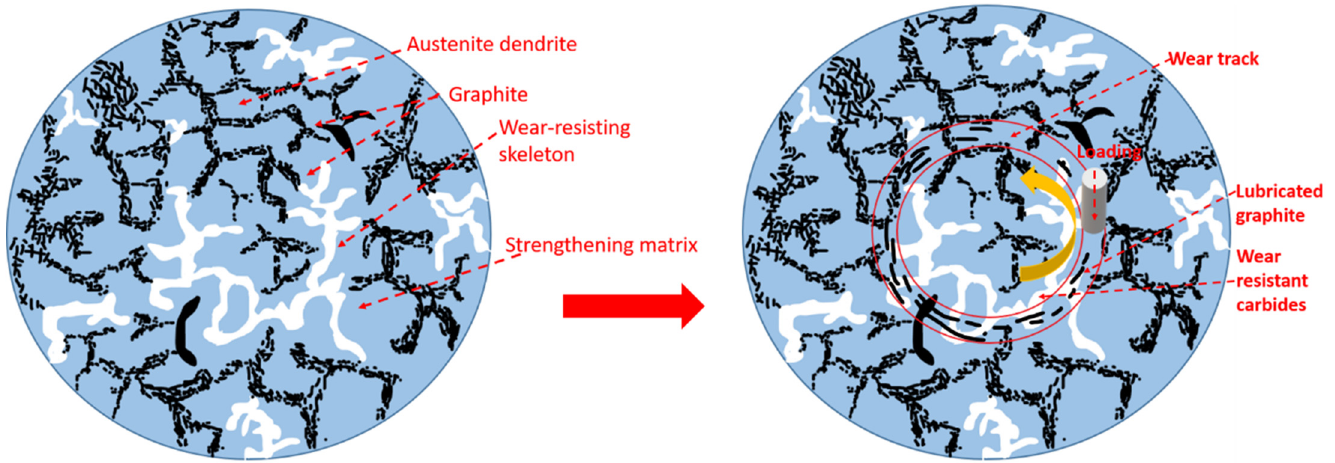
Figure 14. Wear schematic of the iron-based